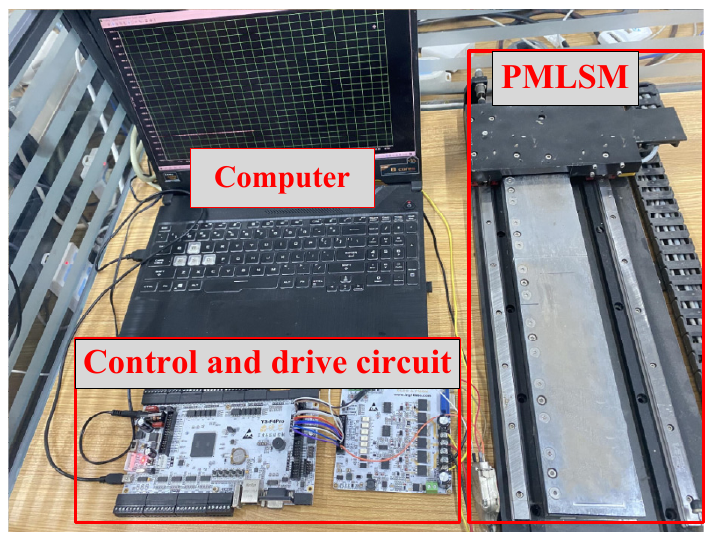
Figure 9. Experimental platform.